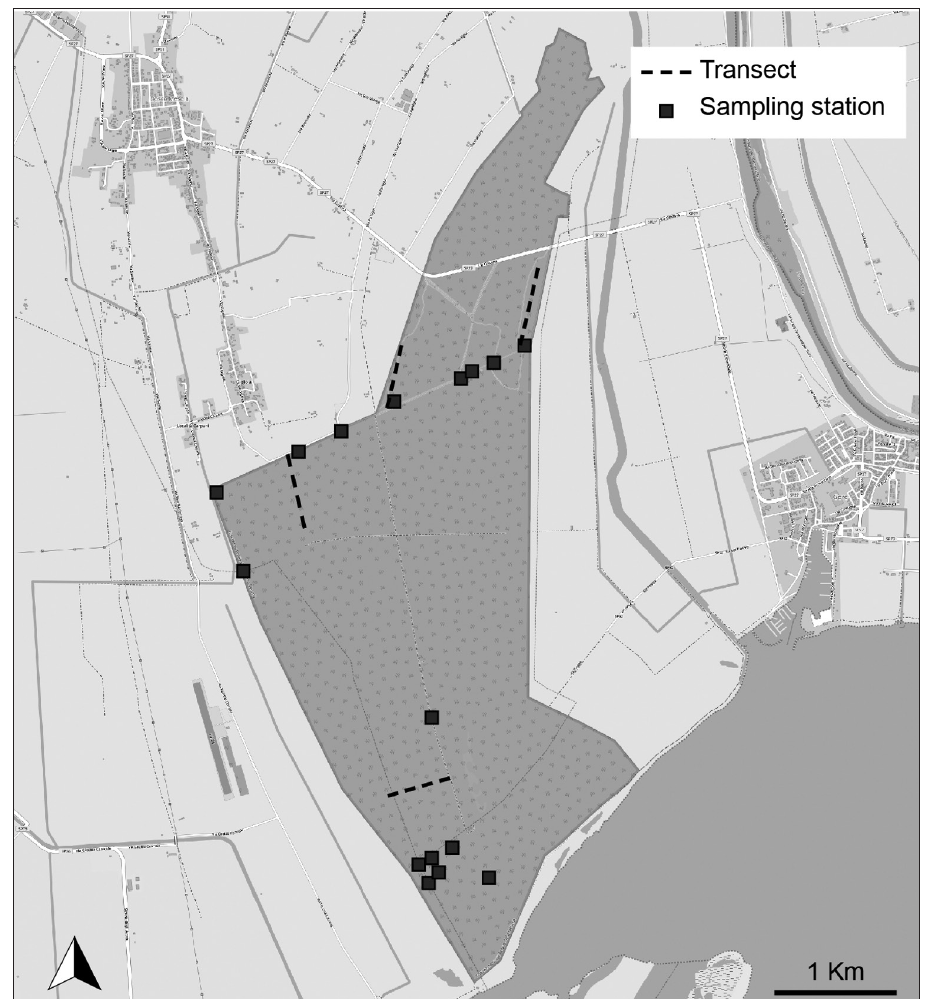
Figure 7. Map of the study area Bosco della The method “Artificial Sap” was tested only in 2015 at Bosco della Mesola, from 25 May to 17 July (Table1). Two kinds of feeding station were used: (i) on trunks of a potentially suitable tree for the presence of C. cerdo and (ii) on trunks of a tree without signs of C. cerdo . All trees selected were oaks ( Quercus ilex and Q. robur ) and suitability was established on the base of vitality and openness of the canopy, presence of exit holes, presence of sap and bark status (Buse et al. 2007). The feeding stations were distributed in 16 replicates: each replicate had both types of feeding stations (overall 32 oaks were selected). Each replicate was checked once a week (eight replicates on Tues- day and eight on Thursday) from 21:30h to 22:30h. In the afternoon (about 18:00h- 19:00h), the manna of each feeding station was moistened by spraying water on it.